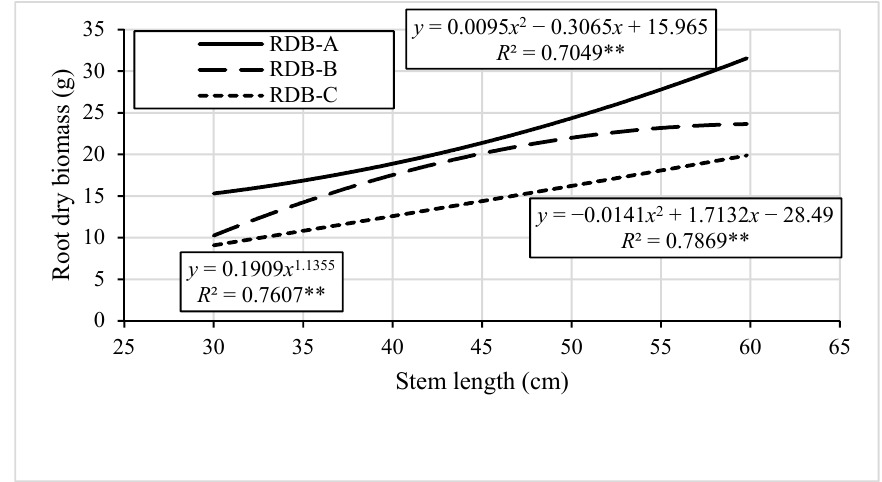
Figure 7. Relationship between stem length and main root dry biomass of maple seedlings in three